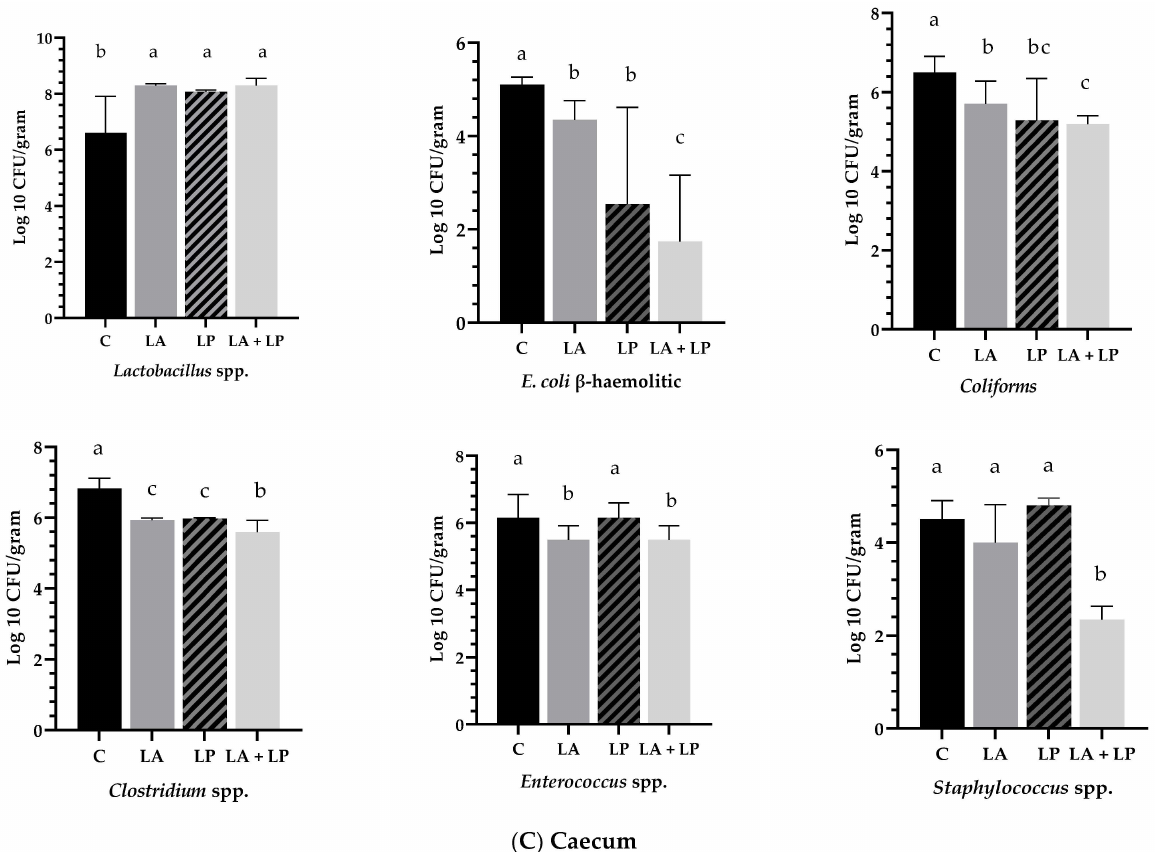
Figure 3. Effect of microencapsulated probiotic supplements on intestinal microflora in the jejunum ( A ), ileum ( B ) and caecum ( C ) of weaning piglets (n = 8/group). C—control diet; LA—control diet supplemented with microencapsulated L. acidophilus ; LP—control diet supplemented with microencapsulated L. plantarum ; LA+LP—control diet supplemented with microencapsulated L. acidophilus and L. plantarum . The results are expressed as (log 10 CFU/g). a, b, c different superscripts within each figure represents significant difference among the groups at p <